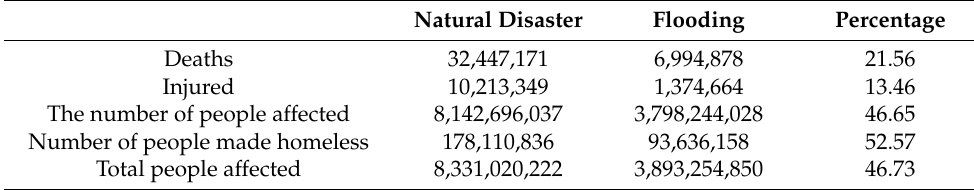
Table 1. Global total casualties of flooding as against natural disasters from 1900–2021. Natural Disaster Flooding Percentage Deaths